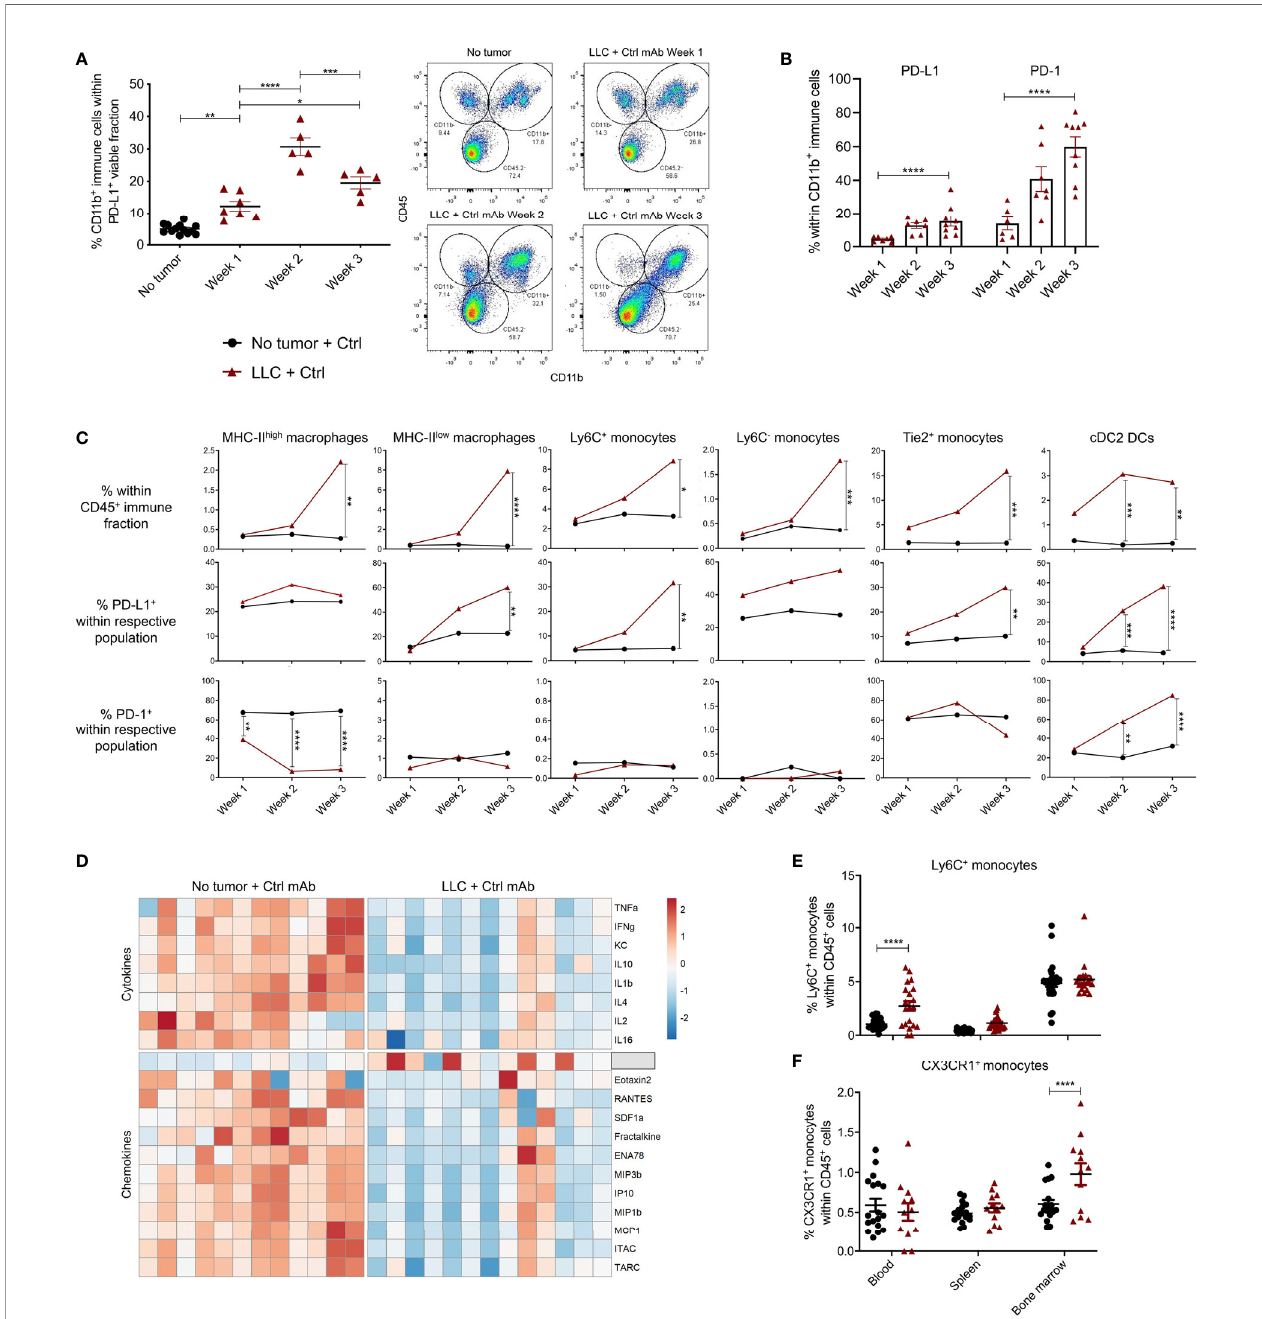
FIGURE 2 | PD-L1 + and PD-1 + myeloid cells in healthy and LLC-engrafted mice. Lungs of healthy and LLC-Fluc tumor-bearing mice were isolated on weeks 1, 2 and 3 after LLC-Fluc challenge to evaluate PD-L1 and PD-1 expression in fl ow cytometry. (A) Summary of percentages of CD45 + CD11b + myeloid cells within the viable PD-L1 + fraction (left panel) with representative dot plots (right panel, n=3, 1-3 mpc). (B) Evolution of myeloid cell-speci fi c PD-L1 and PD-1 expression over time in lungs from LLC-bearing mice (n=3, 1-3 mpc). (C) Follow-up of MHC-II high or MHC-II low F4/80 + macrophages; Ly6C + , Ly6C - or Tie2 + monocytes and CD11b + CD103 - cDC2 within the CD45 + immune fraction from healthy (no tumor) or LLC-engrafted lung tissue over the course of 3 weeks (upper row), next to their respective expression of PD-L1 (middle row) and PD-1 (lower row) (n=3, 1-3 mpc). (D) Heatmap of signi fi cantly altered cytokines and chemokines in serum of mice, collected 3 weeks after challenge with LLC-Fluc or PBS only. Per chemo-/cytokine, concentrations were centered and scaled resulting in a color scale ranging from blue to red for lowest to highest concentration values. Statistics were performed using one-way ANOVA followed by Tukey ’ s multiple comparison test (F-value= 8.97, Df= 2) (n=2, 4-8 mpc). (E, F) Percentage of Ly6C + (E) and CX3CR1 + (F) monocytes, within viable CD45 + single-cells from blood, spleen and bone marrow collected from mice 3 weeks after inoculation with PBS or LLC-Fluc cells (n=3, 5-10 mpc). For panels (A – C, E, F) a two-way ANOVA with Sidak ’ s multiple comparisons test was performed to evaluate statistical signi fi cance. ns, non-signi fi cant; * for p < 0.05; ** for p < 0.01; *** for p < 0.001; and **** for p <